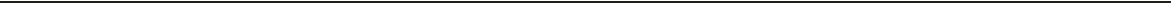
Fig. 7 Acceptor substrate speci fi city, timing of GalNAc modi fi cation, and T5 mAb epitope characteristics. a Schematic of the structure of GPI-APs in various mutant cells. b T5 mAb staining of PIGN-KO cells. (Upper) Surface expression of CD59 and the staining with T5 mAb analyzed by FACS. Dotted lines, background staining; blue lines, 3BT5 cells; red lines, PIGN-KO cells. (Lower) Mean fl uorescence intensity ( ± SD) from three